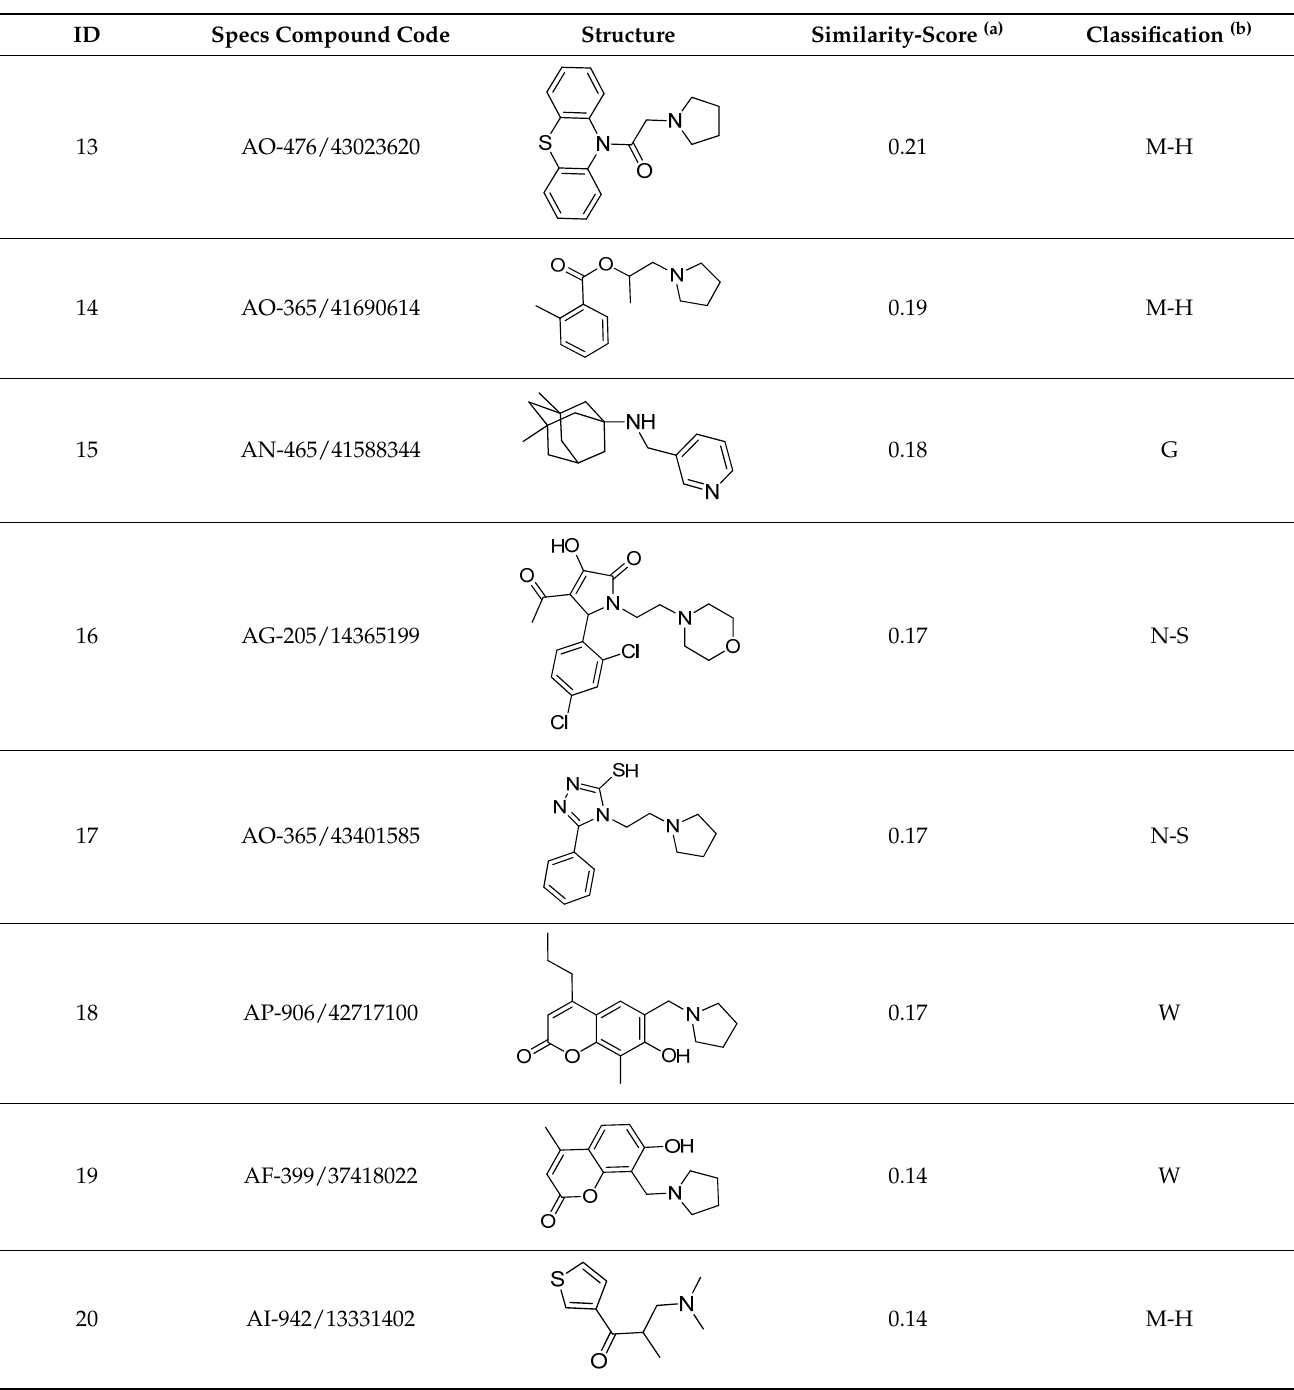
( a ) Similarity score generated by FLAP 2.1 software for descriptor H*O*H. ( b ) Compounds were classified by in vitro trans-stimulation studies in hCMEC/D3 cells as G (good substrate), M-H (medium-high substrate), M-L (medium-low substrate), W (weak substrate) and N-S (non- substrate).